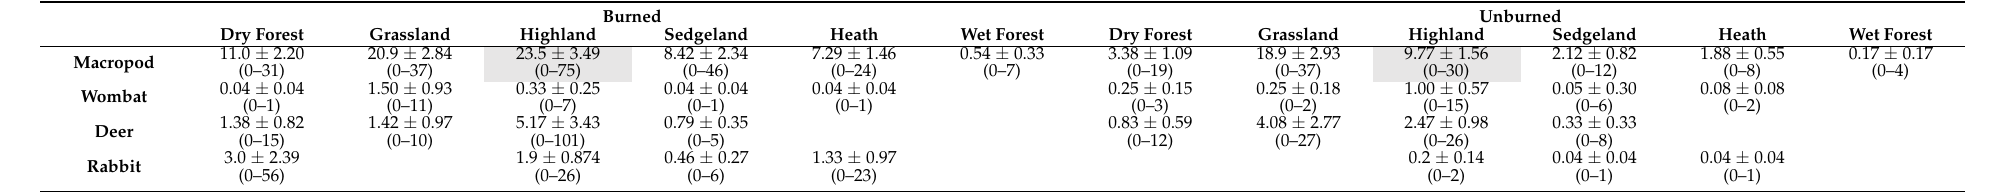
Table 3. Herbivore scat counts in vegetation communities of Tasmania, contrasted between areas that experienced fire in the past three years (‘Burned’) versus adjacent areas that did not (‘Unburned’). Significant differences ( p -value < 0.05) between burned and unburned areas of the same vegetation community are highlighted in grey (e.g., the main effect of burning, blank indicates no scats). Burned Unburned Dry Forest Grassland Highland Sedgeland Heath Wet Forest Dry Forest Grassland